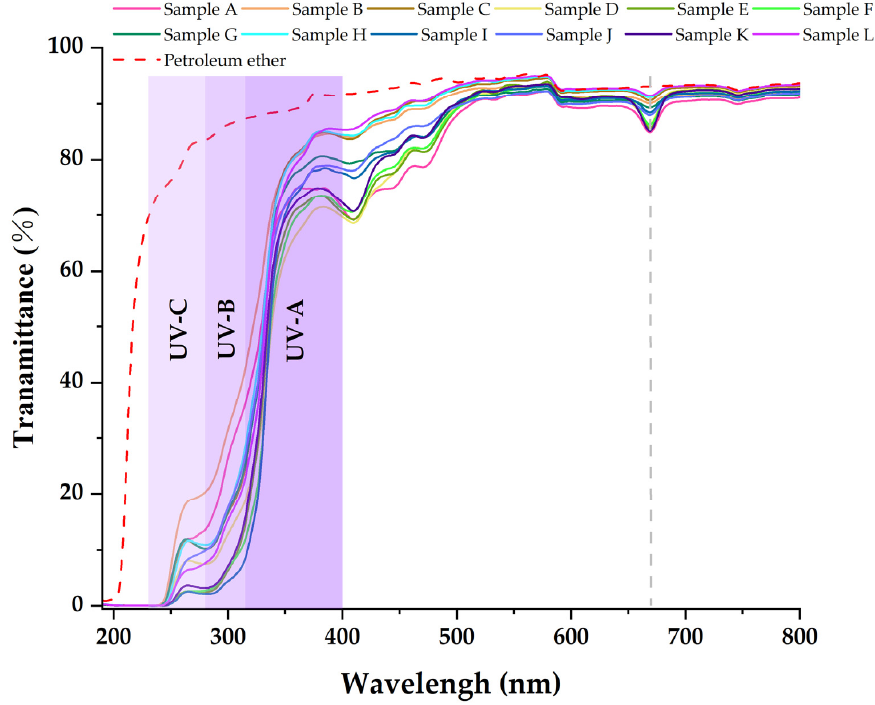
Figure 6. Transmittance spectra of the petroleum ether extractives from Alnus cremastogyne pods.